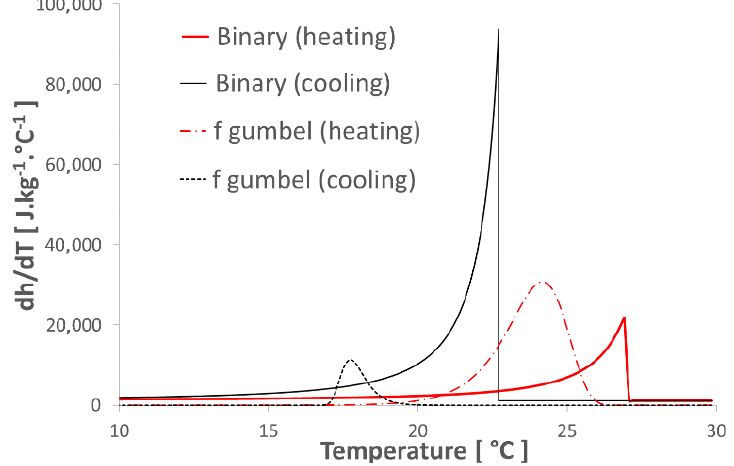
Figure 10. Evolution of the enthalpy derivate of the binary and Gumbel’s functions used to create the hybrid model.